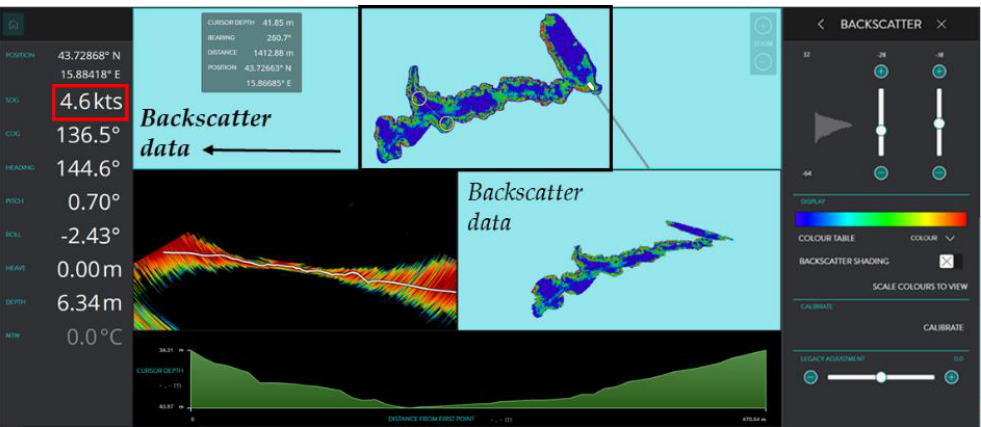
Figure 9. The collected backscatter data with the indicated speed of the Luna boat.